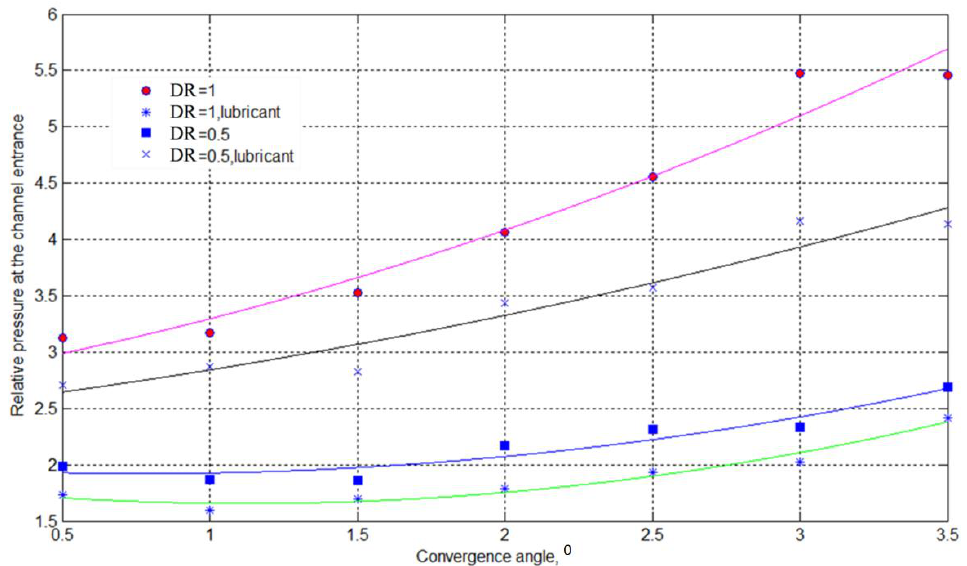
Figure 9. Dependence of the relative pressure at the entrance to the radial channel on the conver- gence angle.